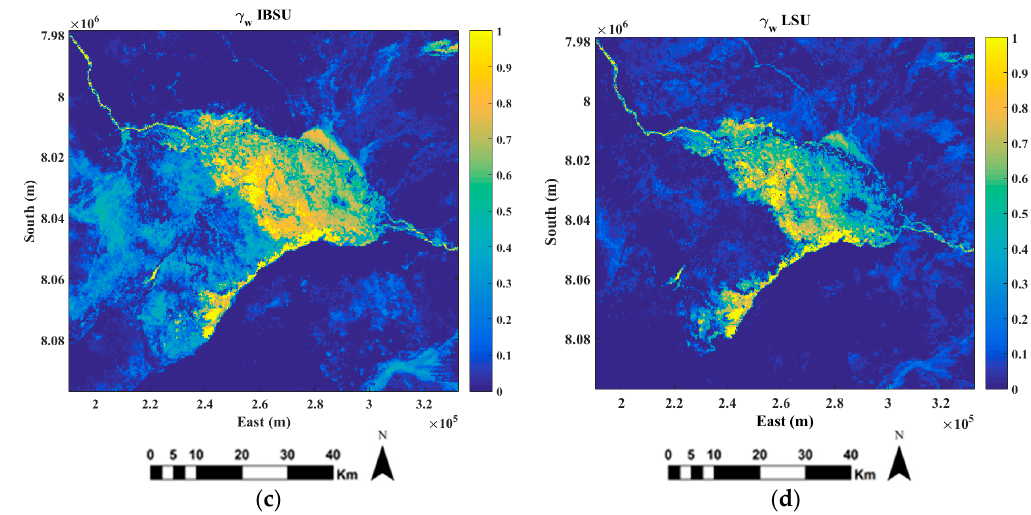
Figure 14. γ w maps as produced by applying ( a ) IBSU and ( b ) LSU on the 17 April 2008 TM image, compared to ( c ) IBSU and ( d ) LSU applied to the MERIS image of the same date.